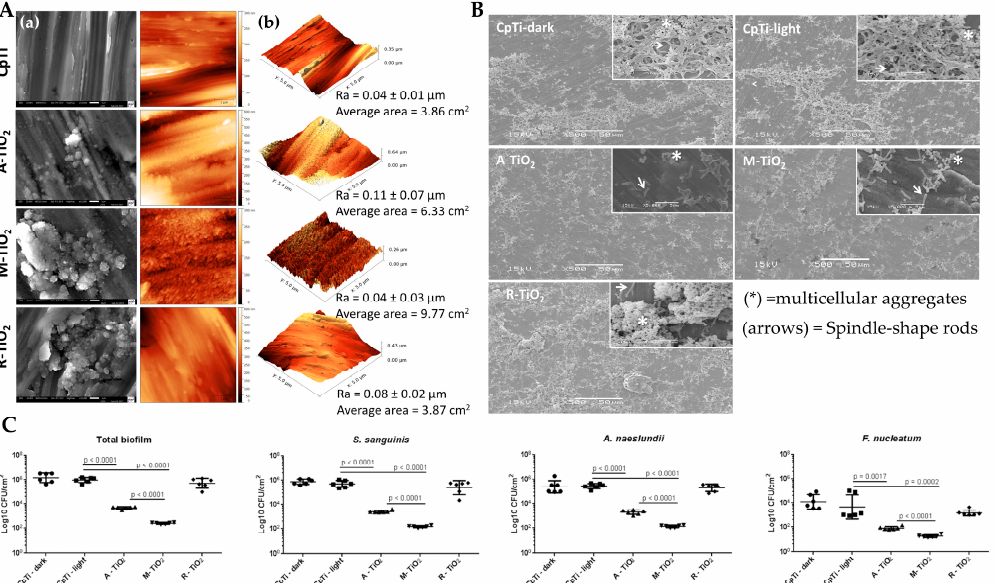
Figure 3. ( A ) SEM ( a ) and AFM ( b ) analyses of different samples; ( B ) SEM micrographs of biofilms formed on different samples; ( C ) Colony-forming units (CFUs) on surfaces of different sample after 1 h of UVA light irradiation [48].